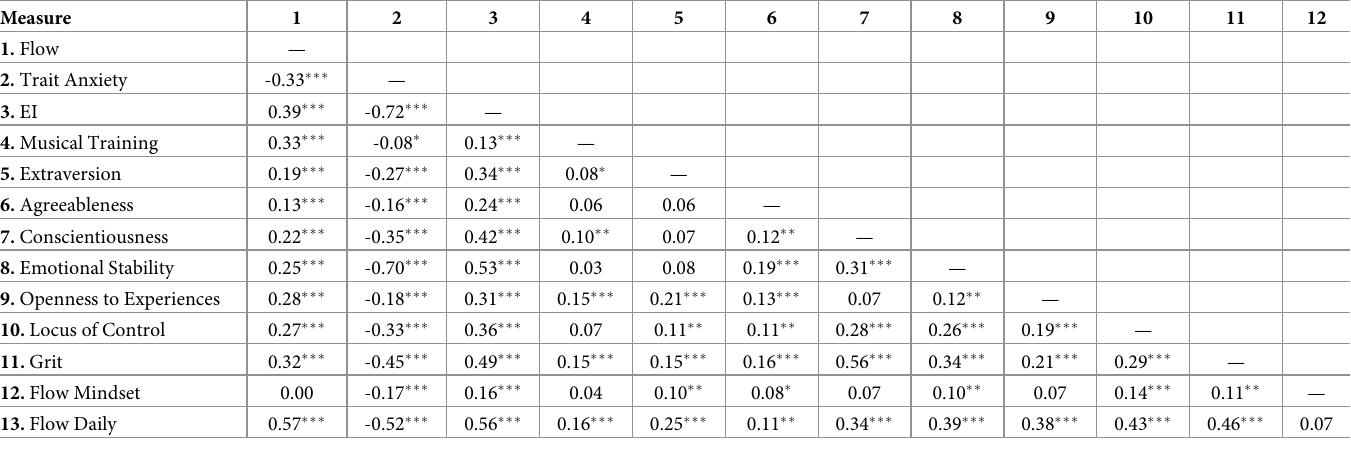
Table 3. Pearson’s r correlations between the main variables. Measure